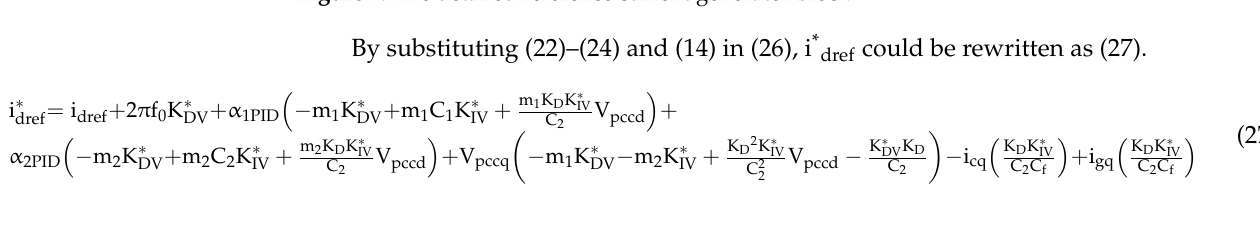
Figure 7. The detailed reference current generator